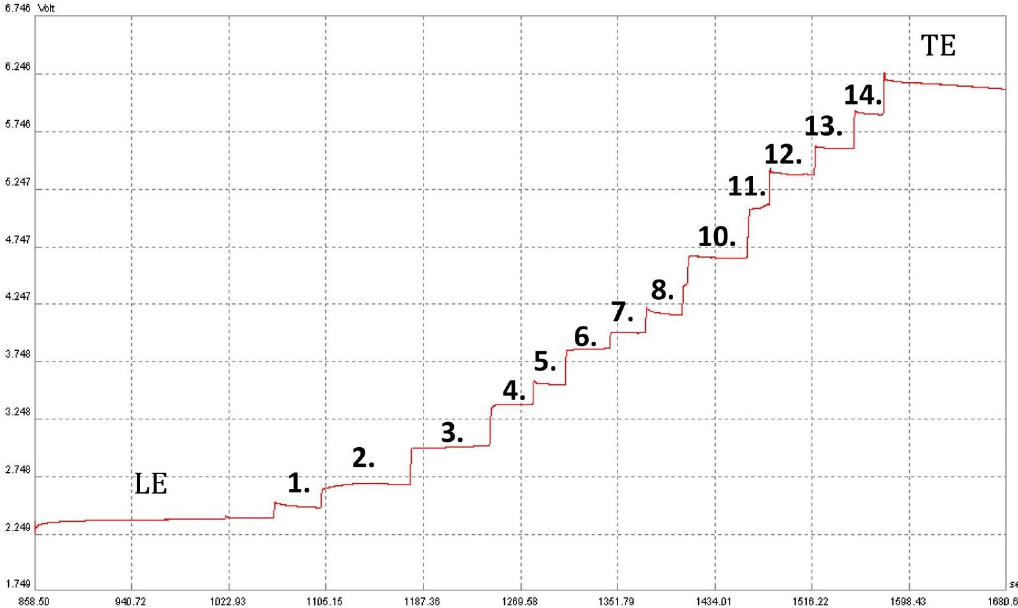
Figure 1. Isotachophoretic separation of acids in a standard mixture of fourteen acid anions (iso- tachophoregram). Zone assignments: LE—leading electrolyte; 1—nitric acid; 2—thiocyanic acid; 3—oxalic acid; 4—formic acid; 5—pyruvic acid; 6—citric acid; 7—phosphoric acid; 8—lactic acid; 9—succinic acid; 10—acetic acid; 11—ascorbic acid; 12—propionic acid; 13—butyric acid; 14—valeric acid; TE—terminating electrolyte.